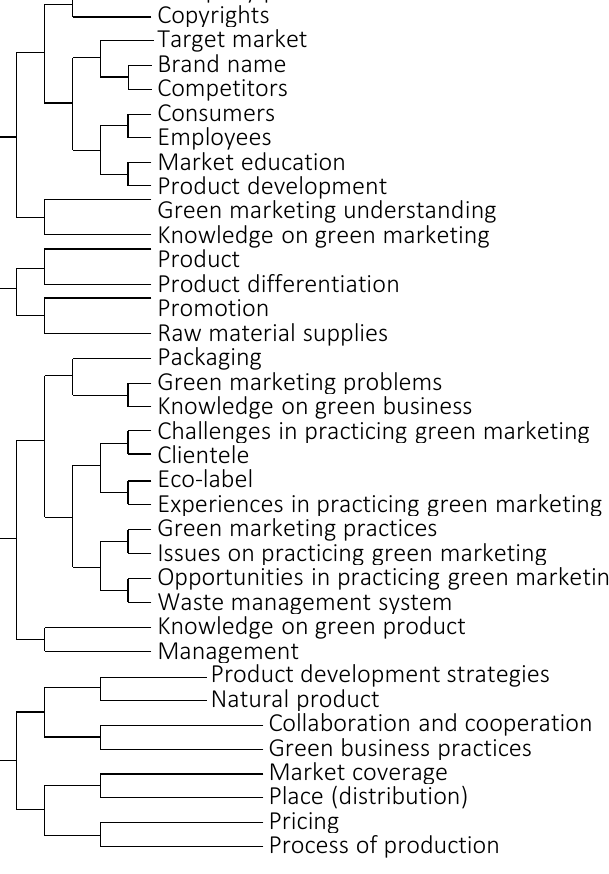
Figure 1. Dendrograms of marketing practices